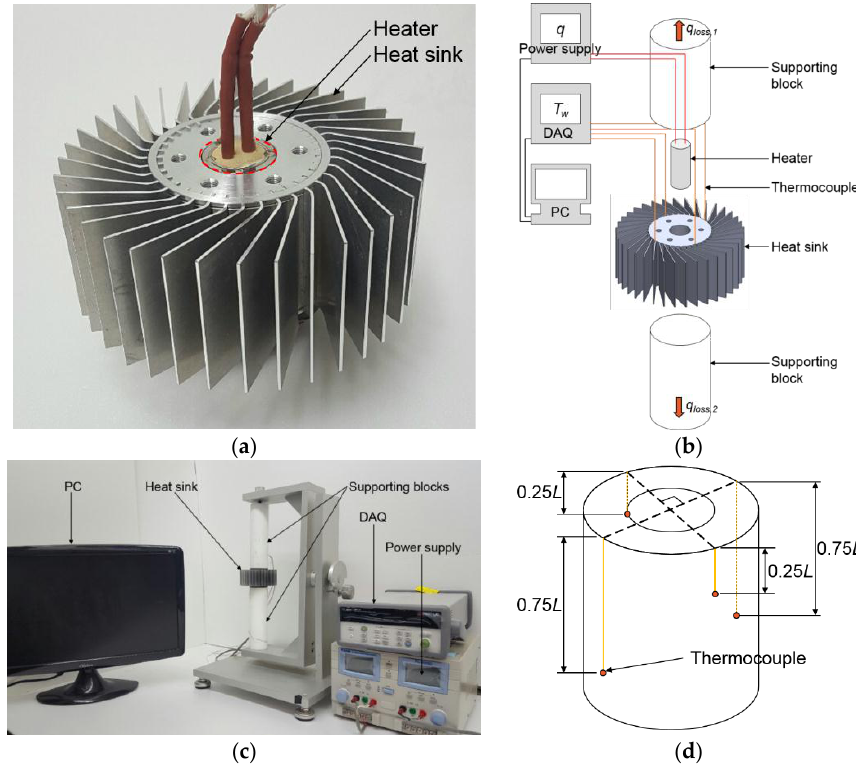
Figure 3. Experimental setup. ( a ) photograph of a heat sink assembly; ( b ) schematic diagram of experimental apparatus; ( c ) photograph of experimental apparatus; ( d ) positions of thermocouples.